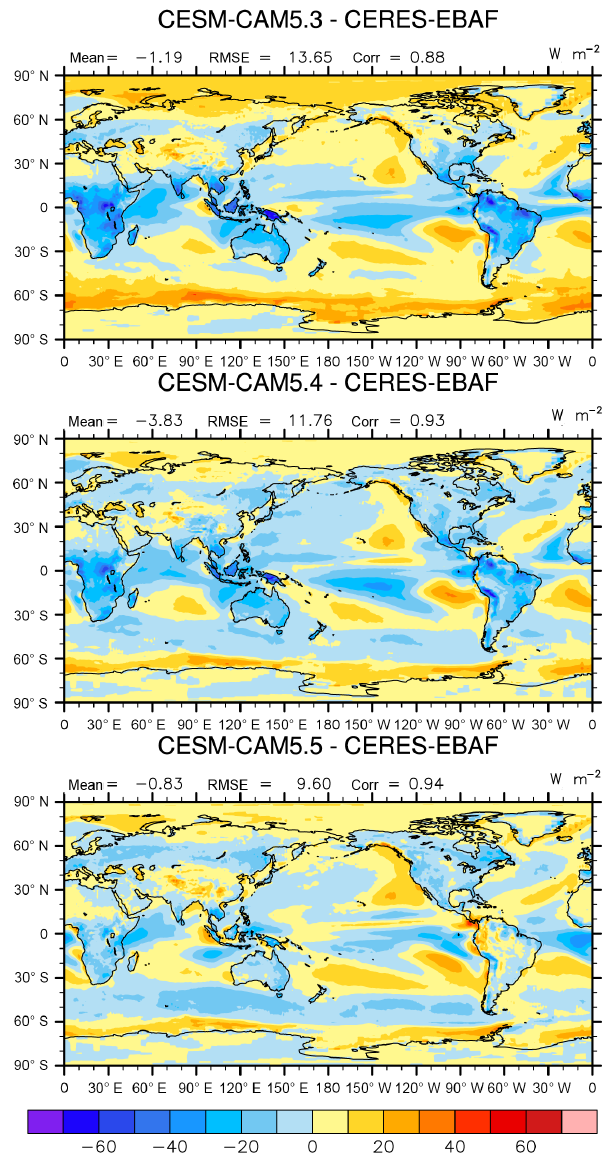
Figure 2. Shortwave cloud forcing biases as computed relative to CERES-EBAF for (top) CESM-CAM5.3 (years 402 to 426), (middle) CESM-CAM5.4 (years 75 to 100), and (bottom) CESM- CAM5.5 (years 100 to 125) for the pre-industrial control run. Each configuration displays the difference from the observed mean, root mean squared error, and pattern correlation